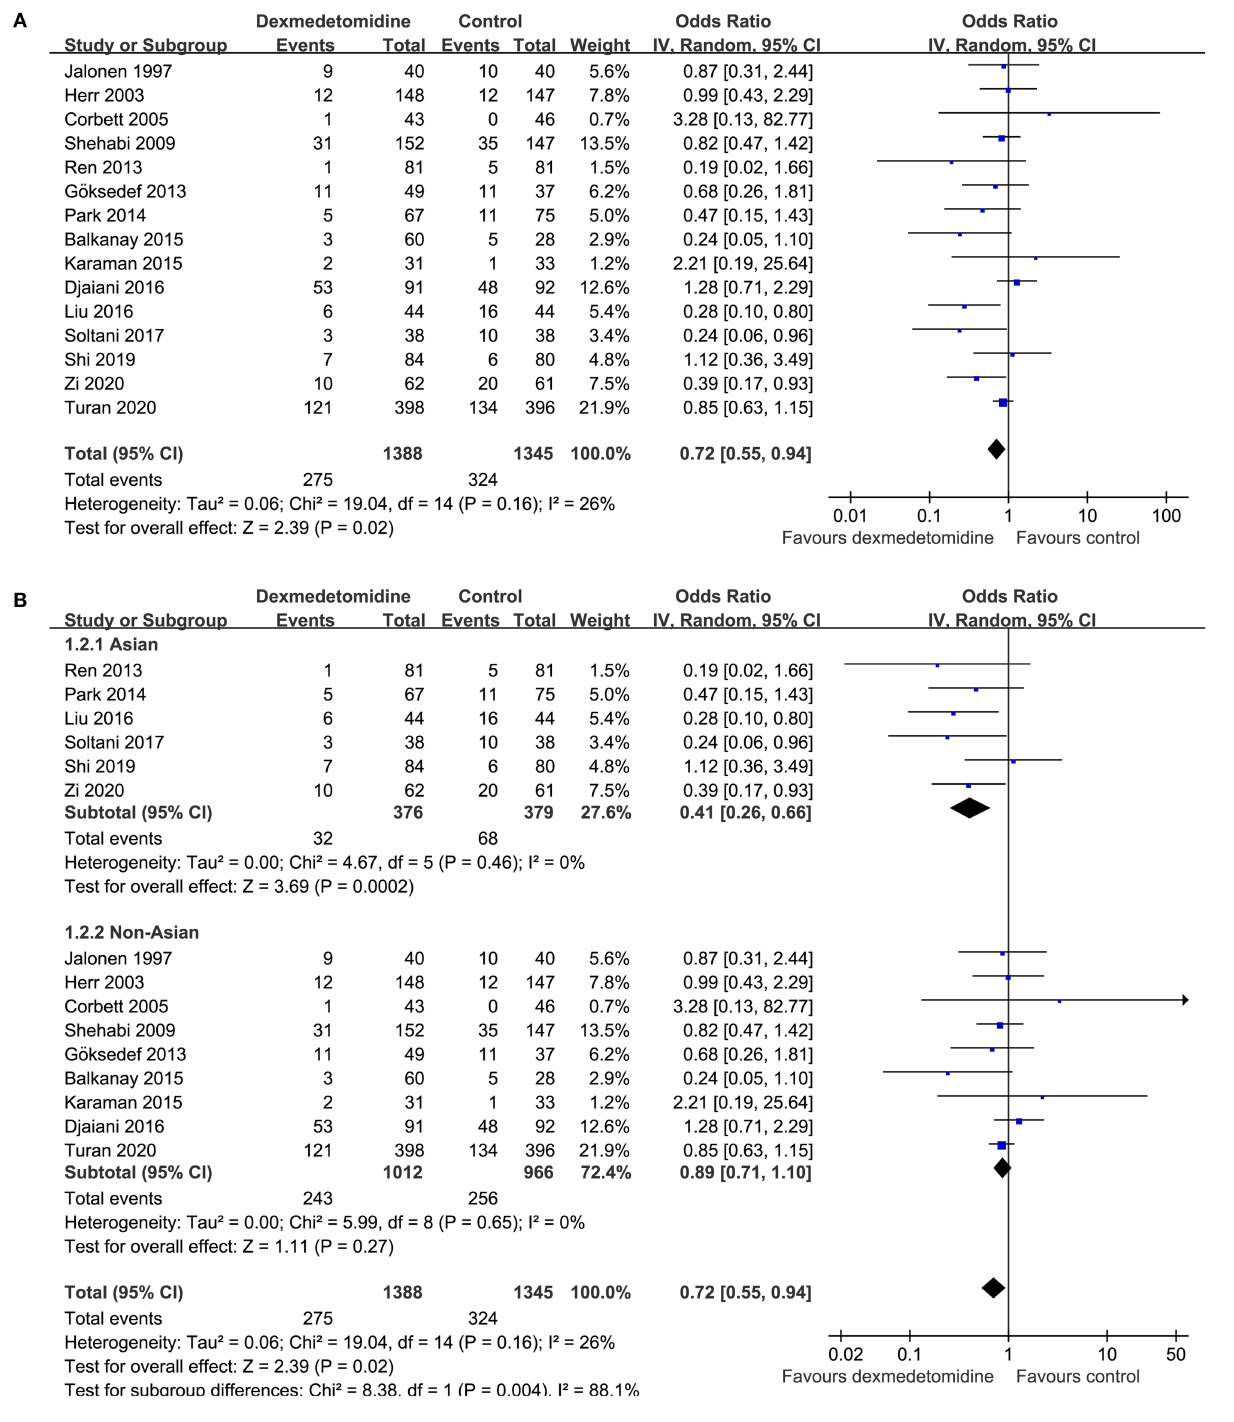
FIGURE 2 | Forest plots for the meta-analysis comparing the influences of dexmedetomidine and controls on the incidence of POAF after cardiac surgery; (A) overall meta-analysis; and (B) subgroup analysis according to the origin of the studies.